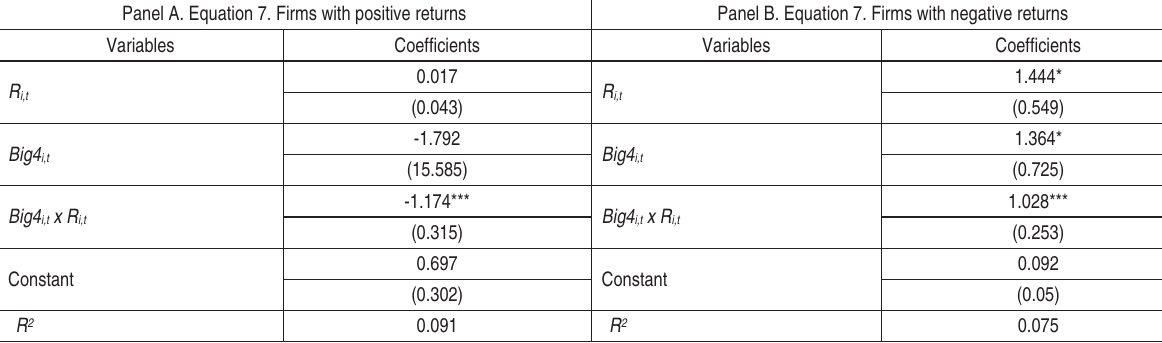
Table 5a. Earnings sensitivity and conservatism Panel A. Equation 7. Firms with positive returns Panel B. Equation 7. Firms with negative returns